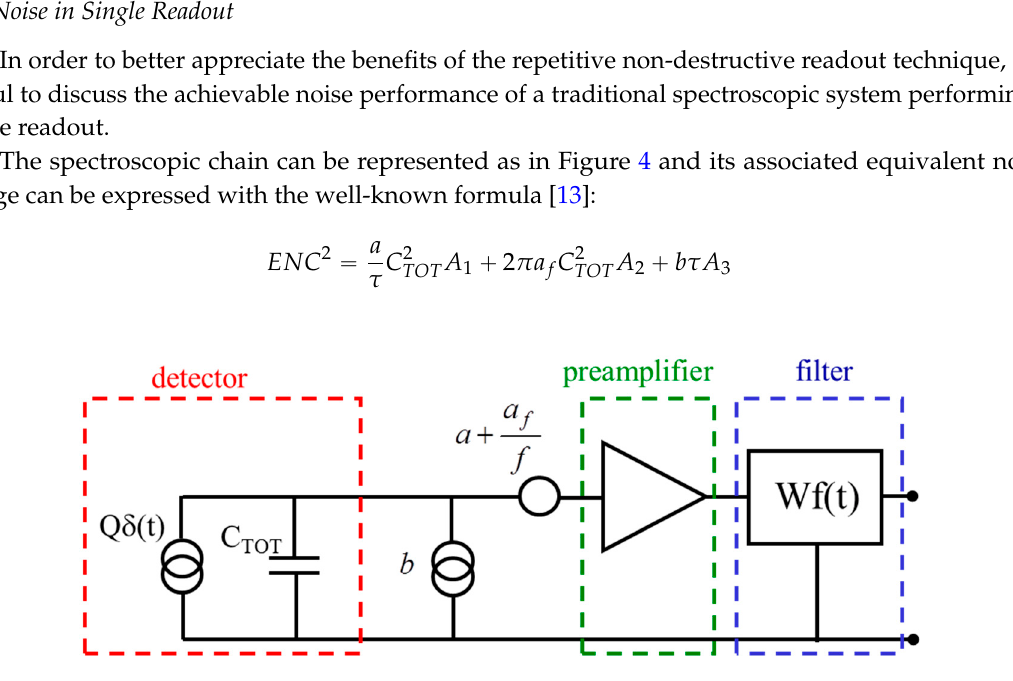
Figure 4. Schematic of a typical spectroscopic chain. The detector is modeled as a delta-like current source in parallel to a capacitance. The input referred noise sources are represented. In this work we consider only the series noise sources (white and 1/f) and a filter triangular weighting function Wf(t).